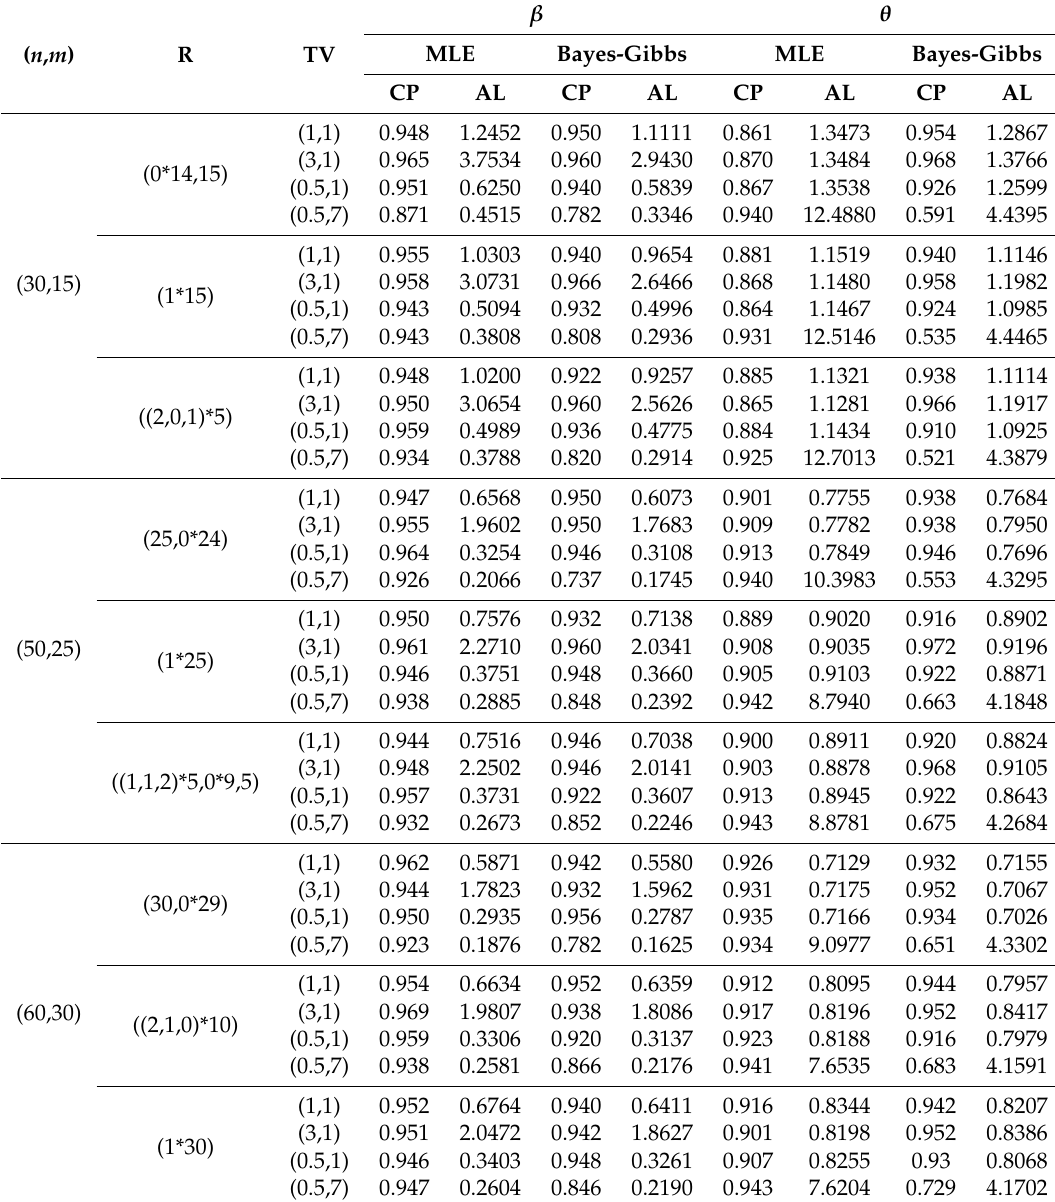
Table 5. CP and AL of 95% intervals when T =